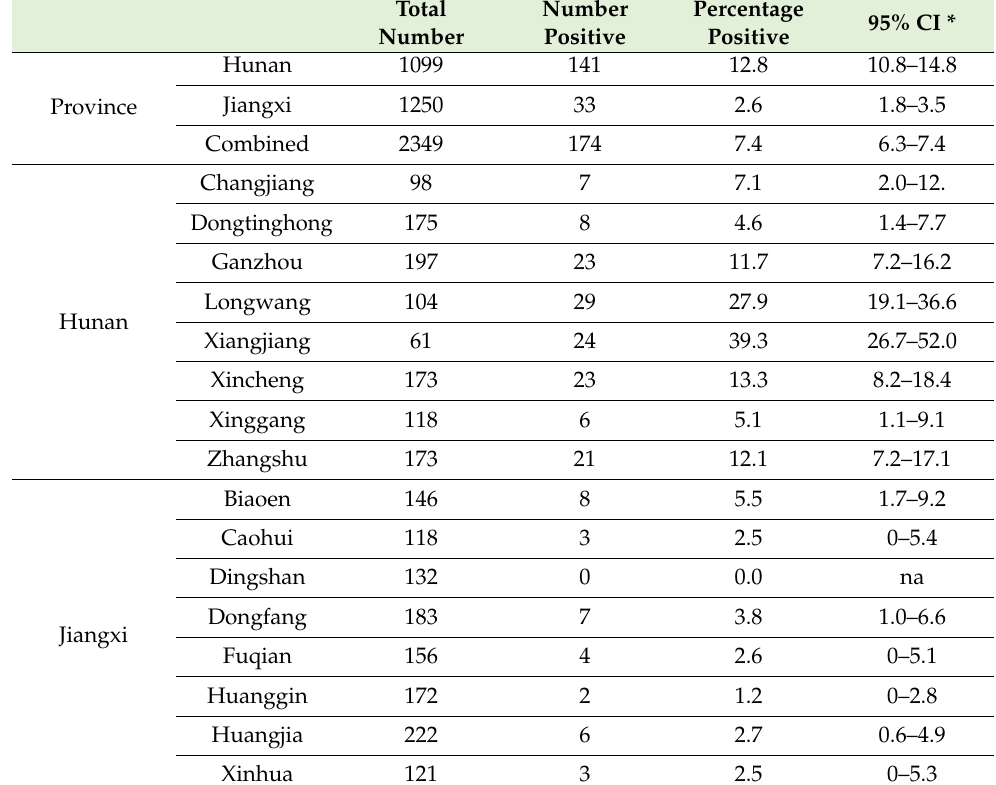
Table 2. Household prevalence of schistosomiasis at the province and village levels, determined by real-time PCR.